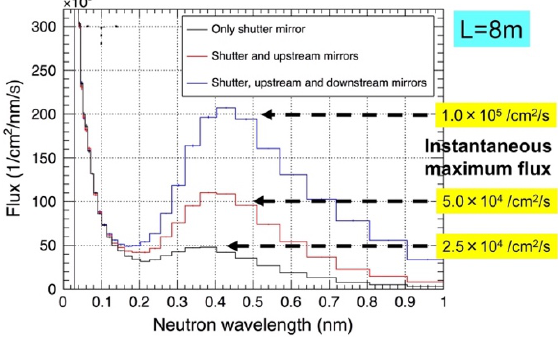
Fig. 3. Neutron flux at L=8 m